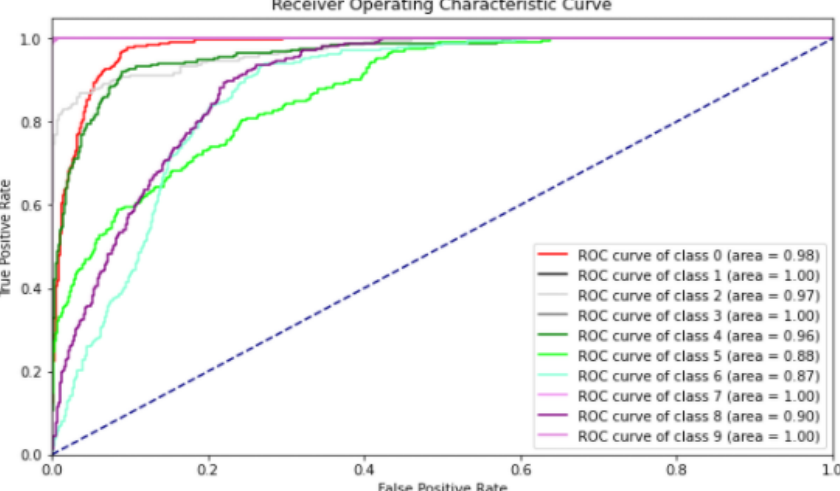
Figure 12. ROC curve of the proposed DAE + MS-CRNN model.